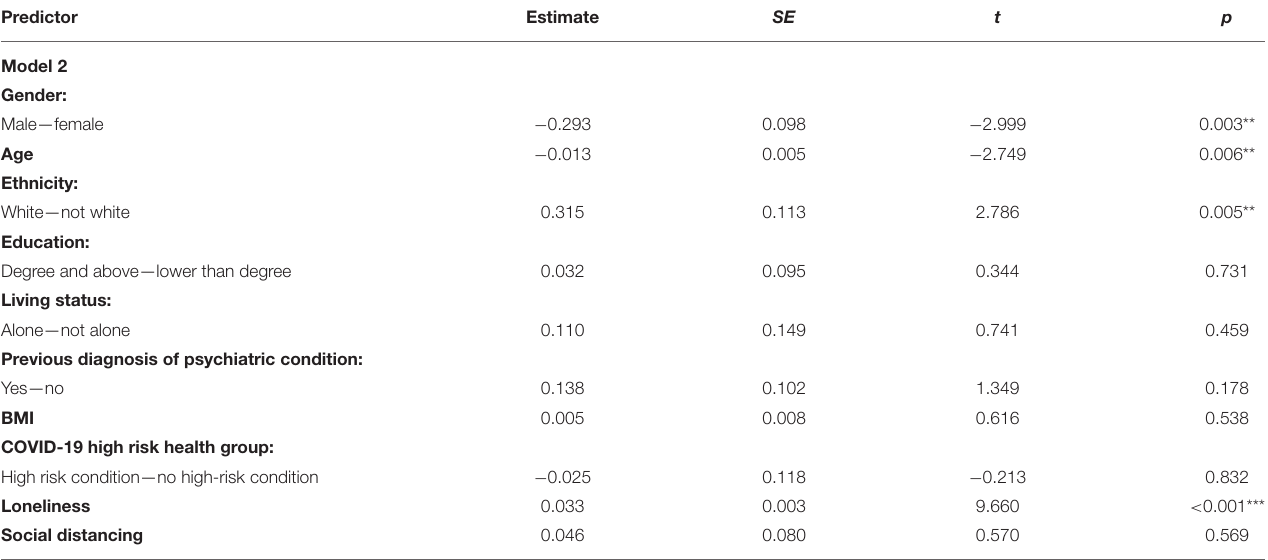
TABLE 5 | Results of multiple linear regression on change in depression. Predictor Estimate SE t p Model